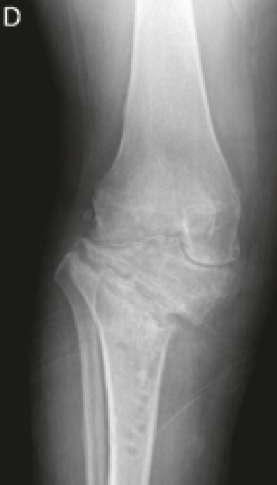
Figure 9: September 2013, after multiple debridements and ar- throscopic washout and synovectomy, X-ray showing severe gonarthritis.